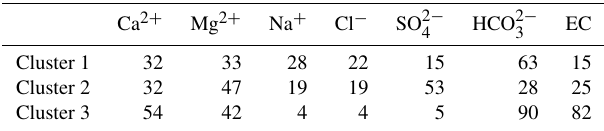
Table 2. Mean proportion in percentage of the major elements in the cluster